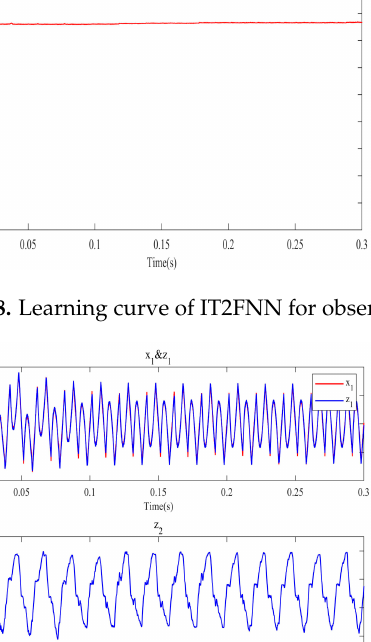
Figure 9. Observation curves of LESO for system state and total disturbance in APF.